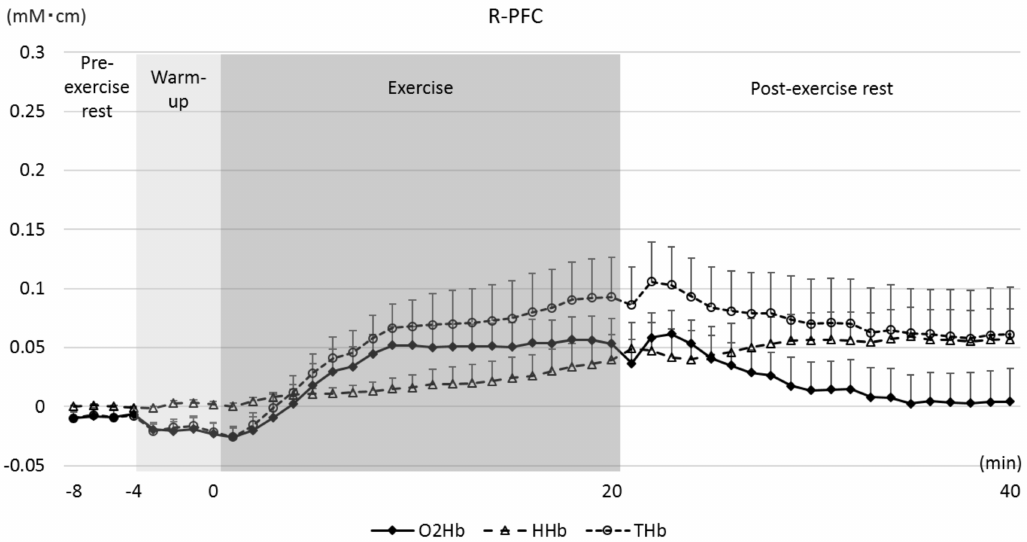
Figure 4. Oxyhemoglobin (O 2 Hb), deoxyhemoglobin (HHb), and total hemoglobin (THb) in the right prefrontal cortex (R-PFC). The circular dotted line represents total hemoglobin (THb) in the R-PFC per minute. Values are presented as the mean ± standard error of the mean (SEM). There was no significant change in O 2 Hb throughout the whole